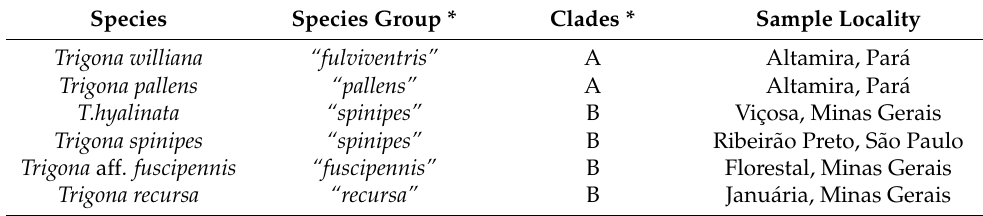
Table 1. Trigona species and respective collection